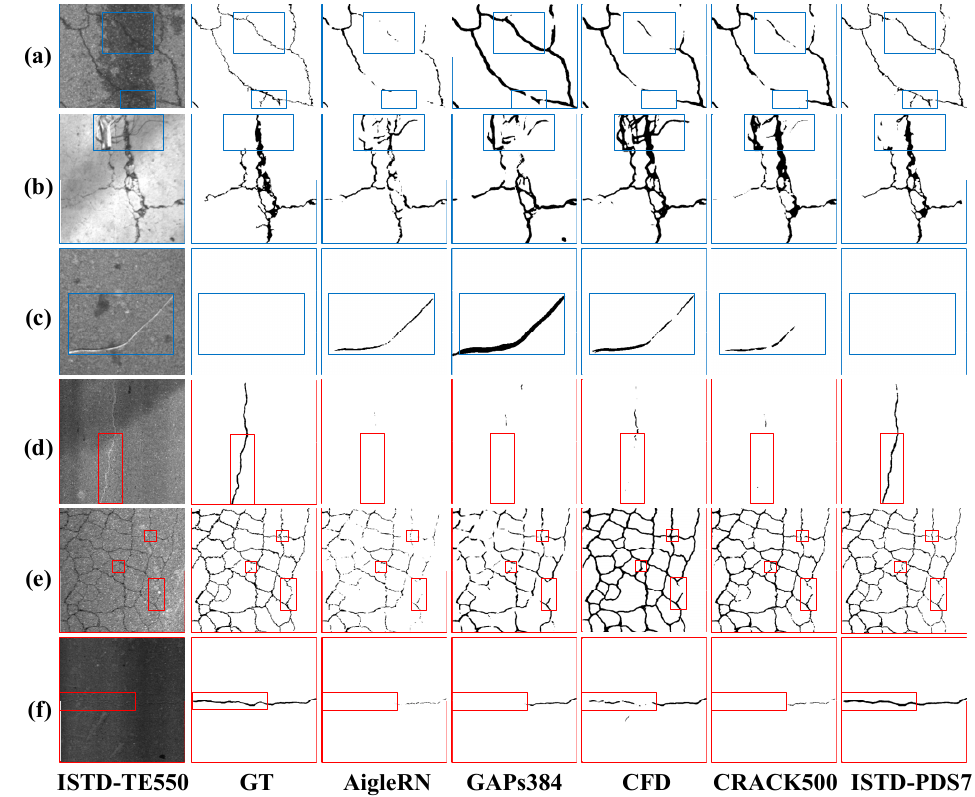
Figure 10. Comparison of the segmentation results of SegFormer after training on di ff erent datasets, (( a – c ) come from ISTD-PDS7; ( d – f ) are come from CrackWH100. The boxes in each image are the focus areas.